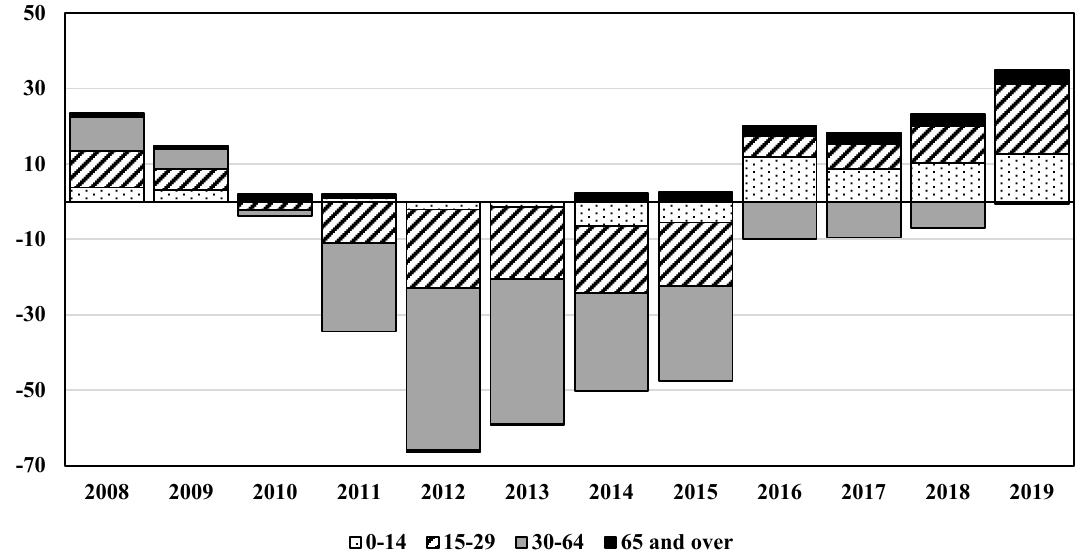
Figure 7. Net migration flows per age groups (thousands), 2008–2019, Greece. Source: ELSTAT and own calculations.